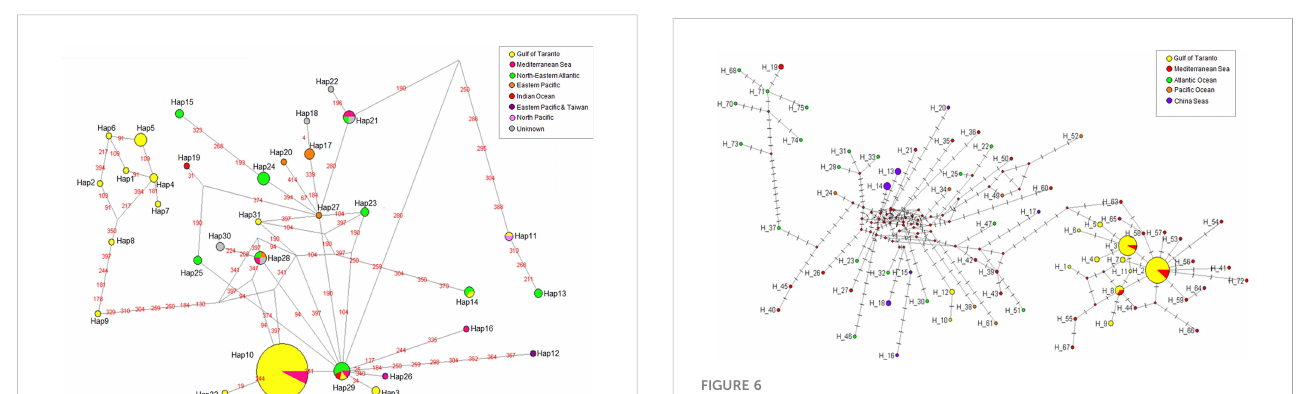
FIGURE 6 Median-joining network of D- loop haplotypes of S. coeruleoalba . The network was constructed using 71 different sequences (Supplementary Table 7). Haplotype frequency distribution in the considered geographic areas is visualized through pie charts using different color codes. For better visualization of the network topology, branch lengths were not maintained proportional to the number of mutations. The latter are indicated by lines parallel to branch lines, each position line describing a mutated nucleotide position with respect to the fi rst sequence in the dataset (Hap-1). Red circles indicate missing intermediate haplotypes.